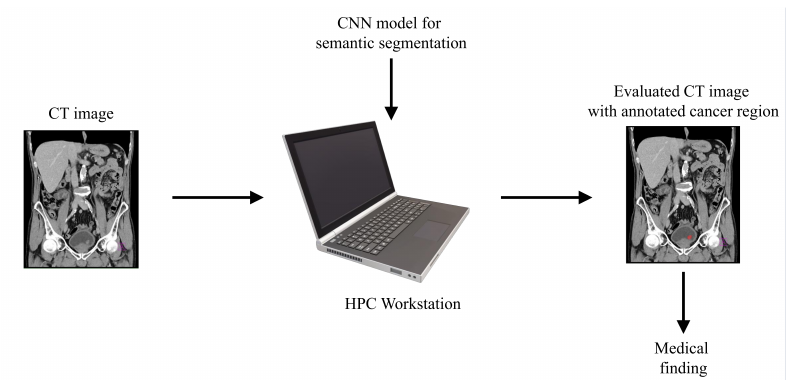
Figure 1. Dataflow diagram of the process of semantic segmentation of urinary bladder cancer from CT images.